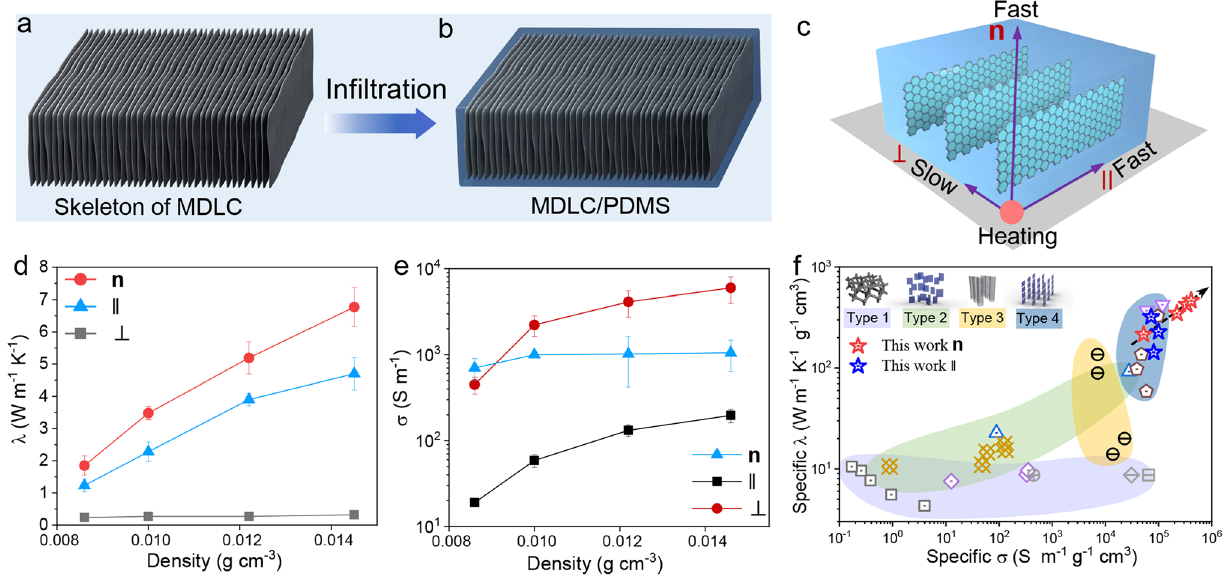
Fig. 5 a Skeleton of MDLCs with thermal graphitization of 3000 °C. b MDLC/ polydimethylsiloxane (PDMS) composites. c Schematic dia- gram of the biaxial thermal conductance. d Thermal conductivity (λ) in three directions ( n , II, ⊥). e Electrical conductivity (σ) in three direc- tions ( n , II, ⊥). f A comparison of specific σ and specific λ of the MDLC/PDMS composites and other composites with different conductive